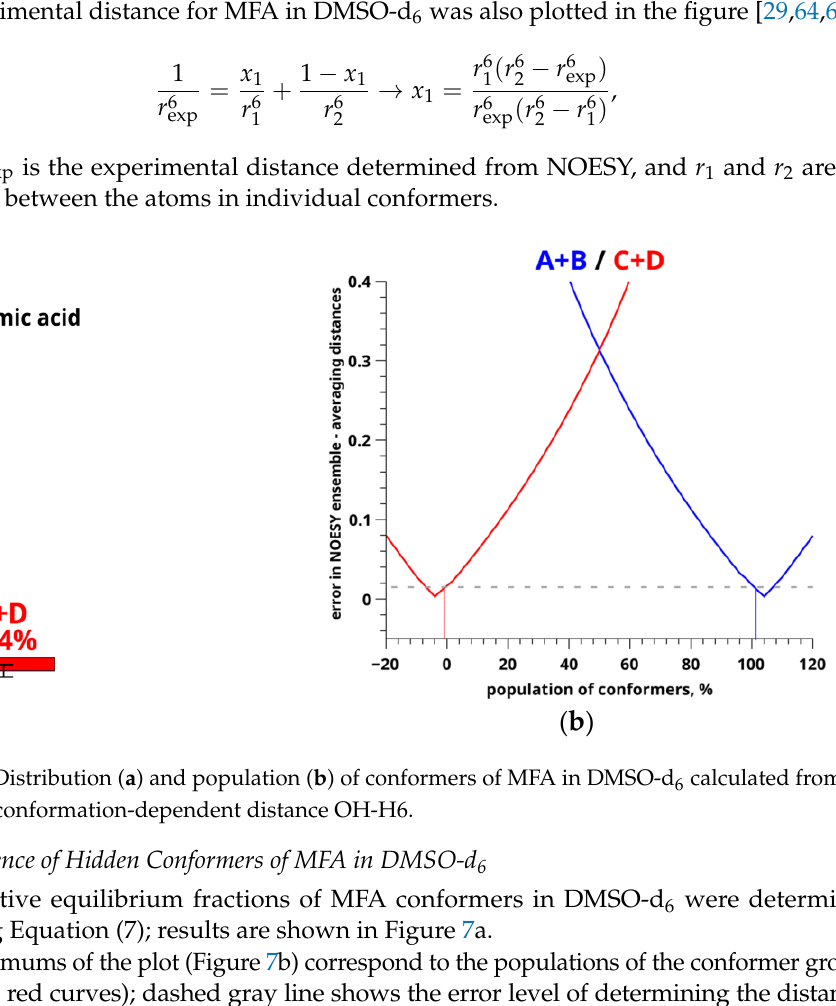
Figure 6. Integral intensity as a function of the mixing time for the conformation-dependent (red